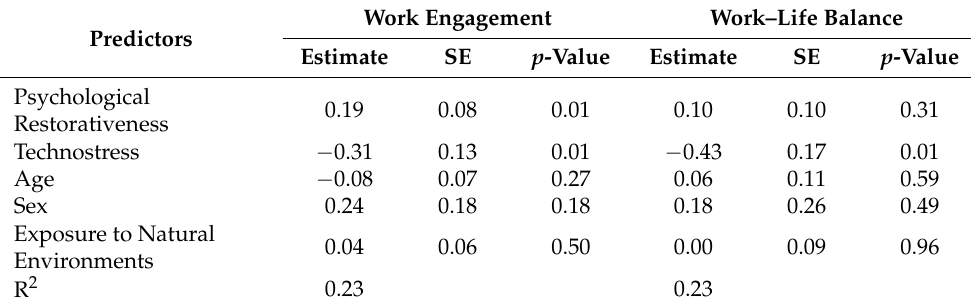
Table 4. Main results: hypothesis